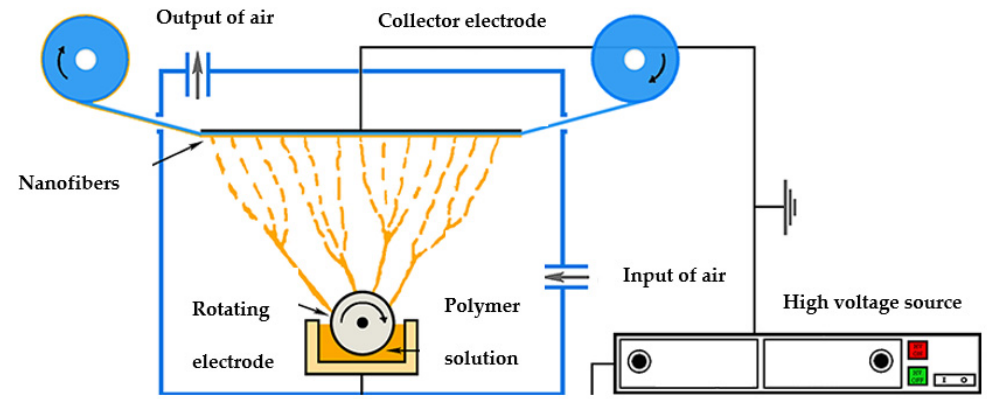
Figure 1. Schematic of the needle-less electrospinning setup. Adapted with permission from reference [11], Sasithorn et al., 2016, originally published under a CC-BY 3.0 license.